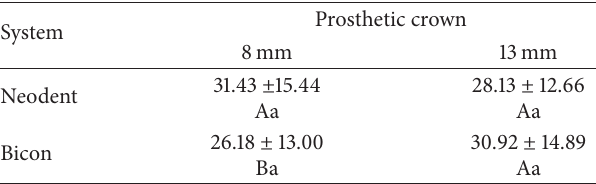
Note. Different uppercase letters represent statistically significant differences between implant systems. Different lowercase letters represent differences between crown heights (Tukey’s test; 𝑃 < 0.05